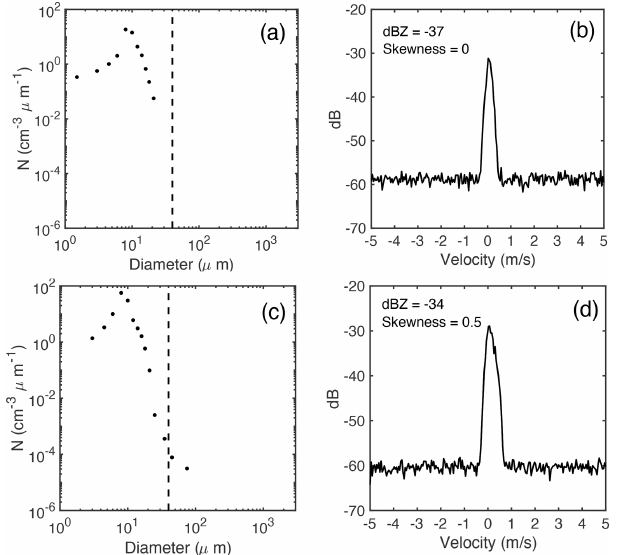
Figure 1. In situ observed DSD of cloud-only conditions (a) and the corresponding simulated Doppler radar spectrum (b) ; the reflec- tivity and skewness of the spectrum are indicated in the upper left corner. Panels (c) and (d) are the same as panels (a) and (b) but for mixed cloud-drizzle DSD. The dashed lines in panels (a) and (c) indicate a diameter of 40µm.